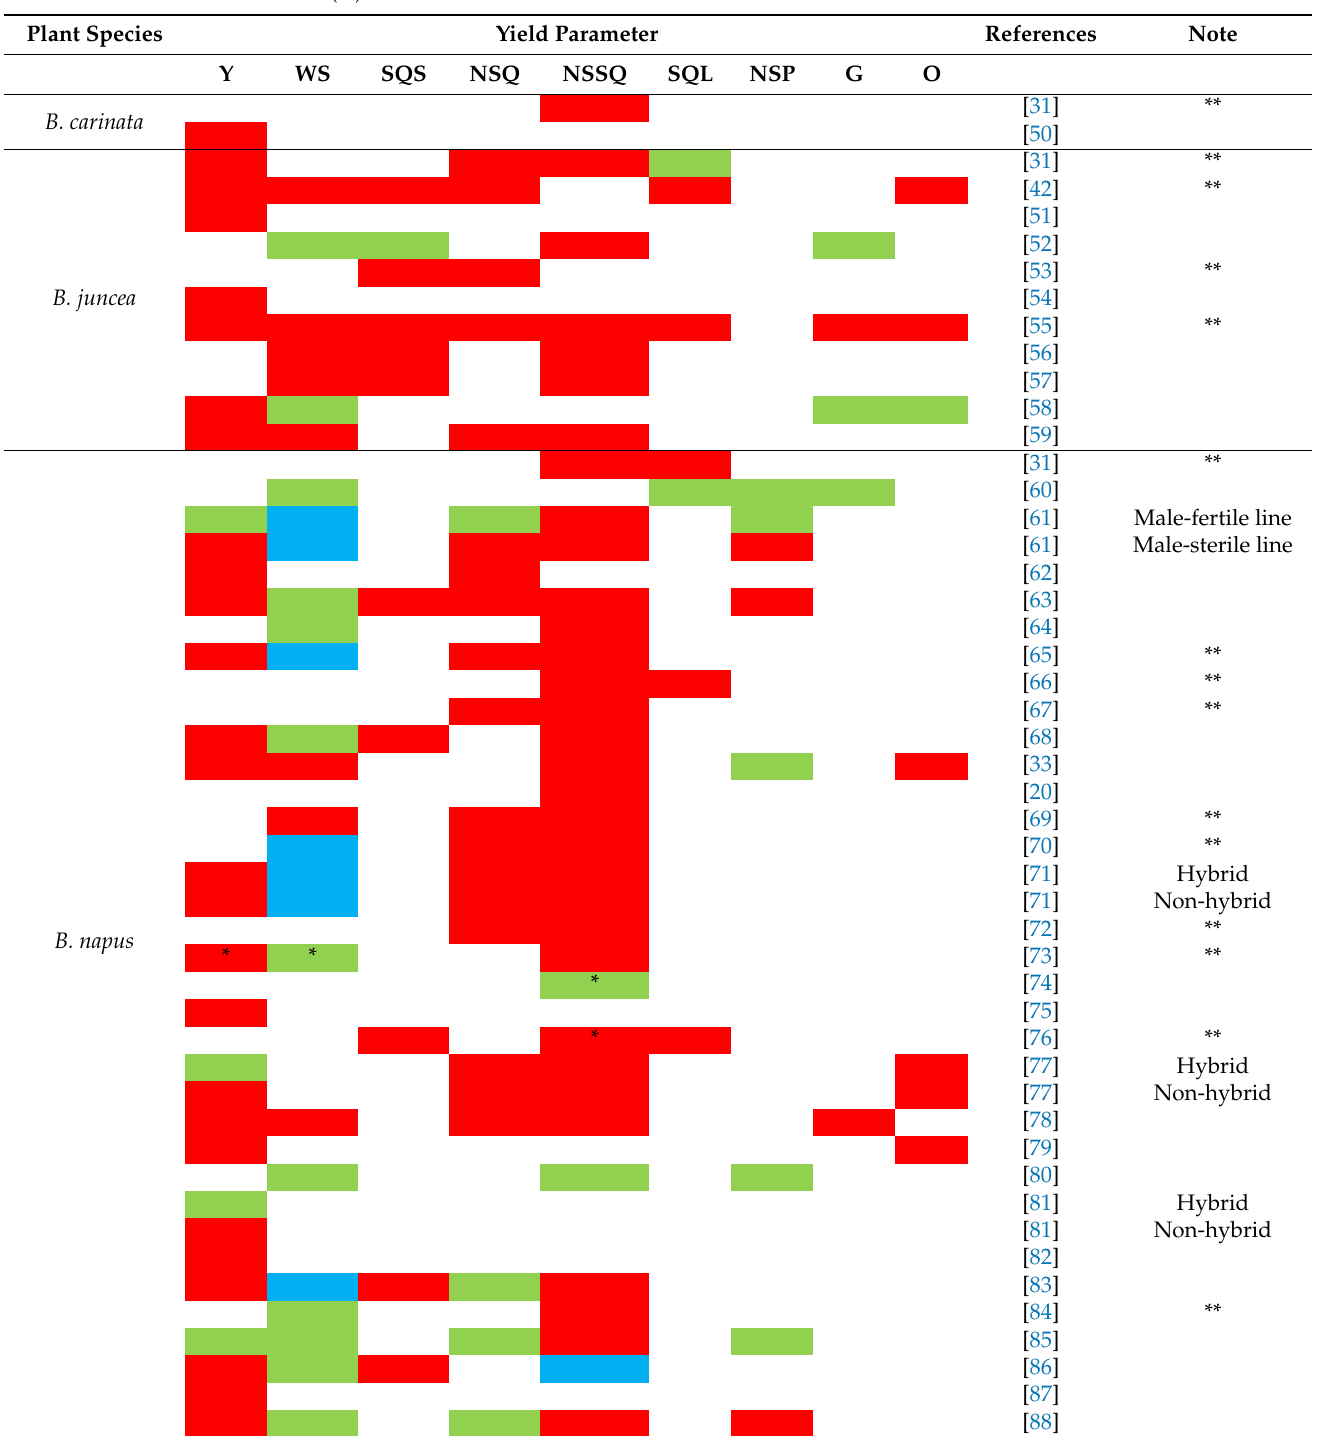
Table 2. Publications were consulted in this review for the main yield parameters (a total of seven or more studies found) which were: seed yield measured as seed weight/(plant, area, or open flower) (Y); weight of seeds (1, 100, or 1000 seeds) (WS); number of siliquae/(plant or area) (NSQ); number of seeds/(silique or open flower) (NSSQ); silique set (SQS); silique length (SQL); number of seeds/(area, plant, or branch) (NSP); seed germination (G); and oil content of seeds (O). An increase, decrease, or neutral effect of insect pollination on yield parameters is shown in red, blue, or green, respectively. Studies included in the meta-analysis for at least one yield parameter are marked with two asterisks (**) in the Note